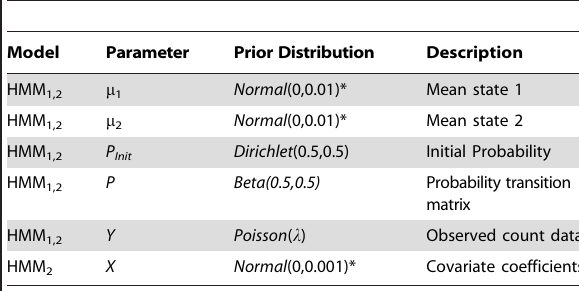
Table 1. Description of prior distributions and hyper-parameters for model